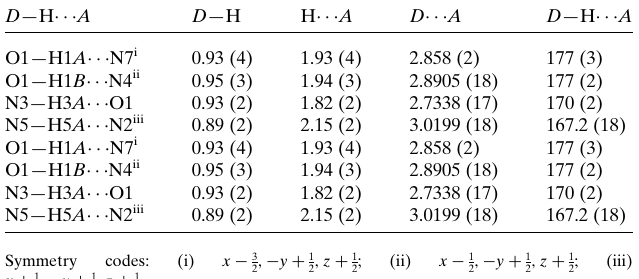
Table 4 Hydrogen-bond geometry (A˚ , (cid:3) ) for (1) (cid:2) H 2 O.